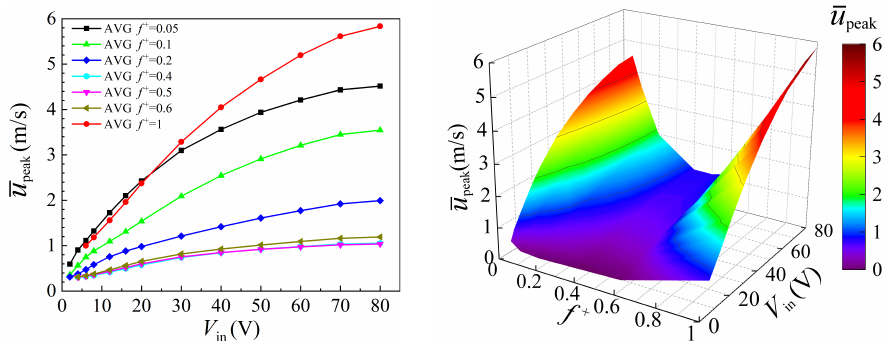
Figure 16. Space-averaged parameter space of synthetic jet at y o = 0.5mm, y o / d o =